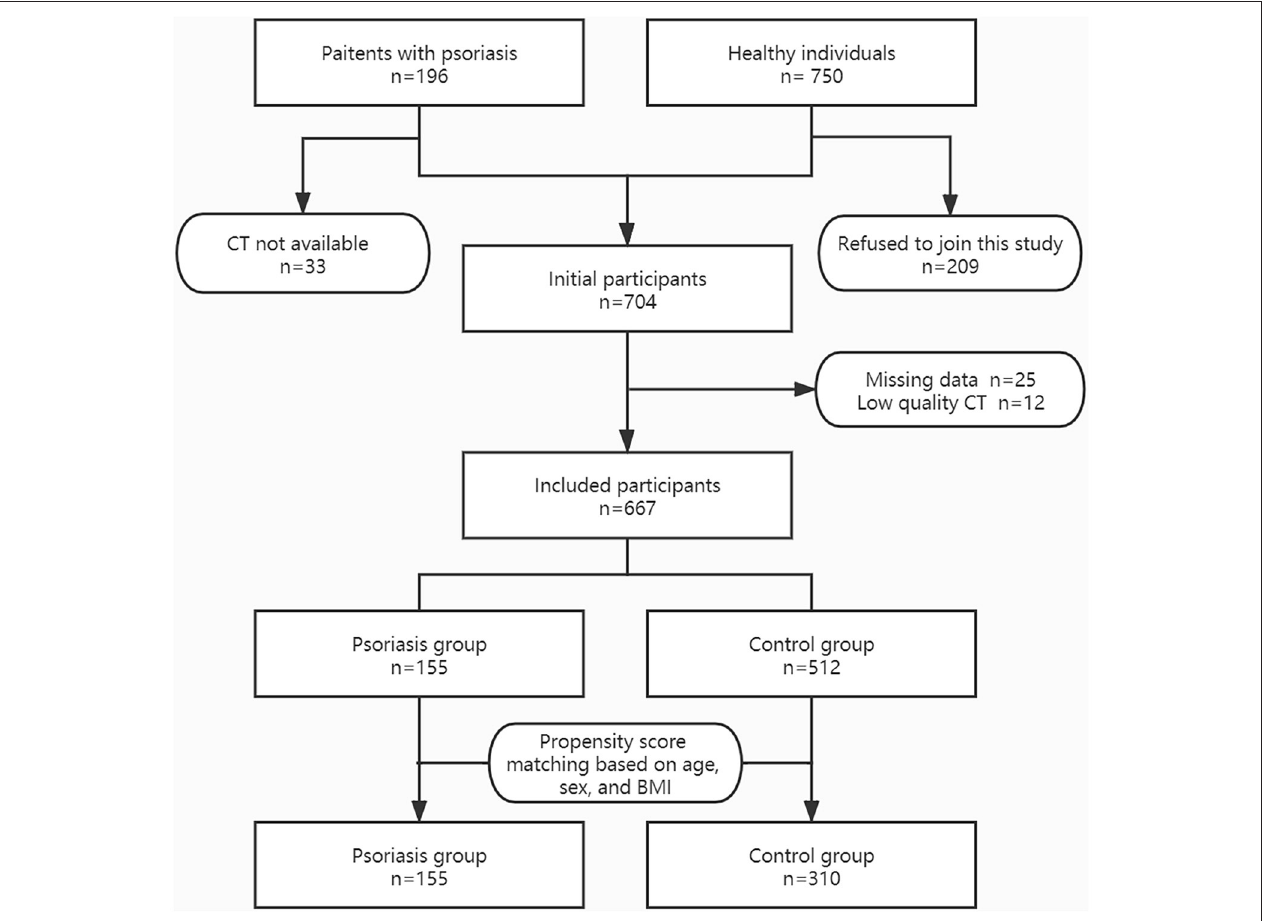
FIGURE 2 | Flow chart of the study population. BMI, body mass index; CT, computed tomography.